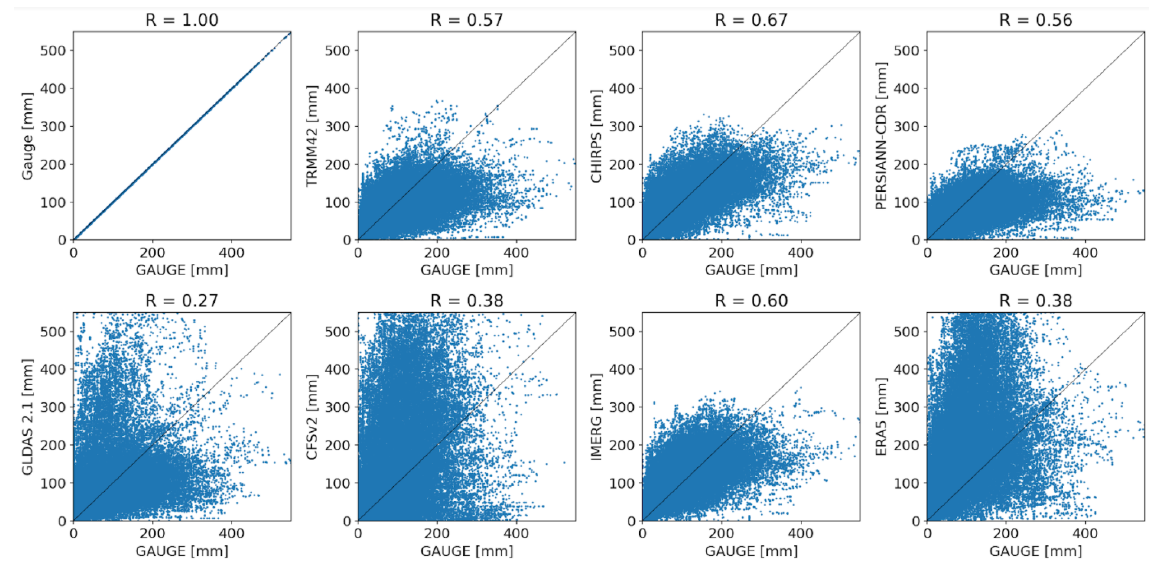
Figure 4. Intensity comparison between satellite-based and gauge-based precipitation based on the cumulative 30d rainfall. Table 2. Performance of satellite precipitation products based on statistical metrics. Metrics TRMM CHIRPS PERSIANN